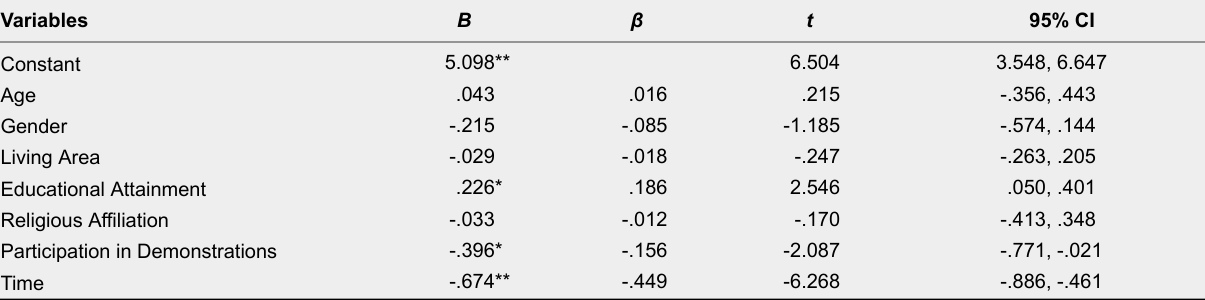
Summary of Regressions Predicting Participants’ Search for